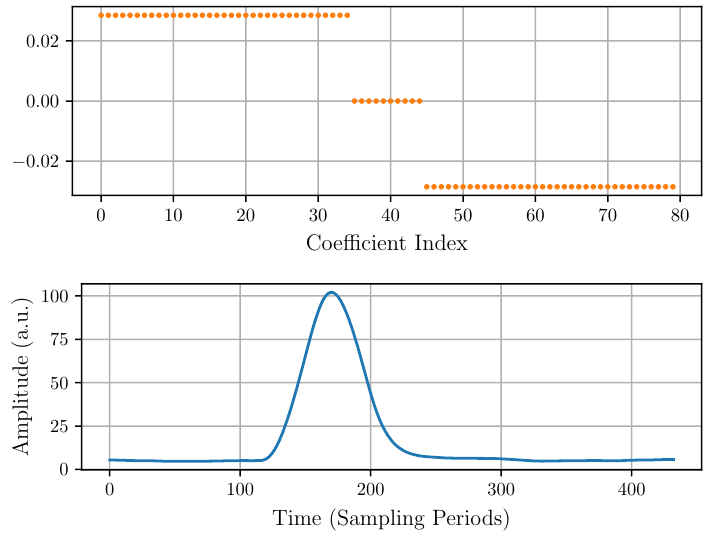
Figure 4. Trapezoidal FIR coefficients ( top ) and the output pulse ( bottom ) corresponding to an experimental input pulse like that of Figure 2.